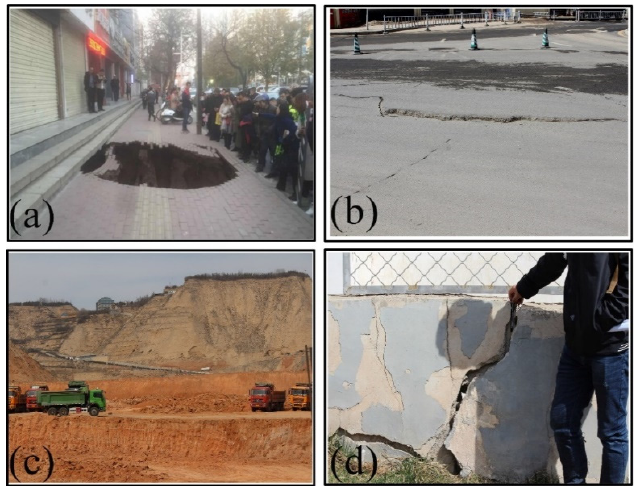
Figure 1. Surface deformation observed in Lanzhou. ( a ) ground collapses, ( b ) road ground sinks, ( c ) creating new land areas by cutting through the mountains and ( d ) cracks and openings in the wall.